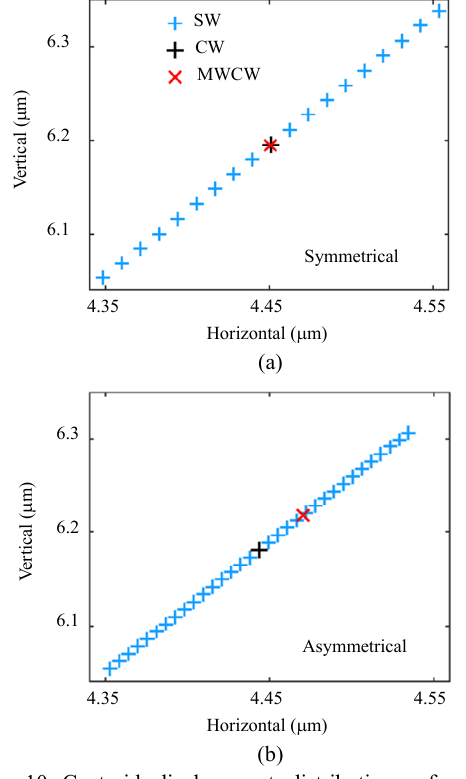
Fig. 10 Centroid displacement distributions of a single sub-aperture for (a) symmetrical and (b) asymmetrical S ( 